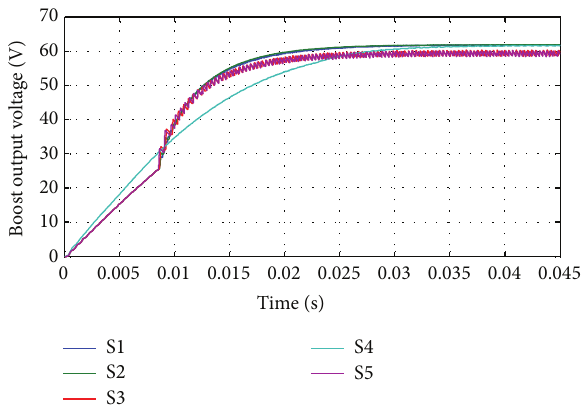
Figure 20: The bar graph for PV